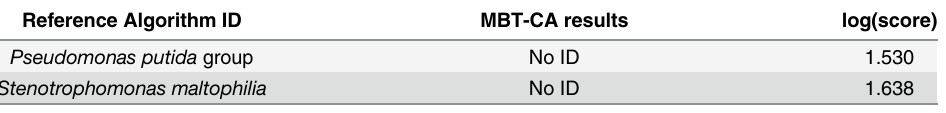
Table 1. Details of MTB-CA System no ID strains.